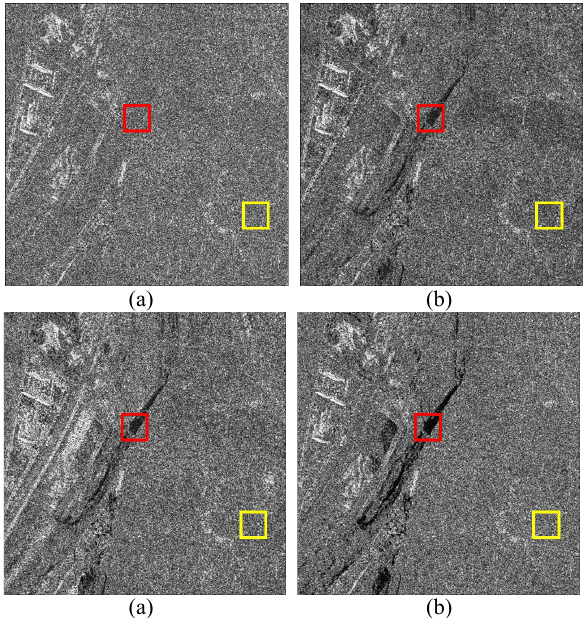
γ . (c) ˆ γ . γ . (b) ˆ α m c γ . (d) Proposed ˆ w